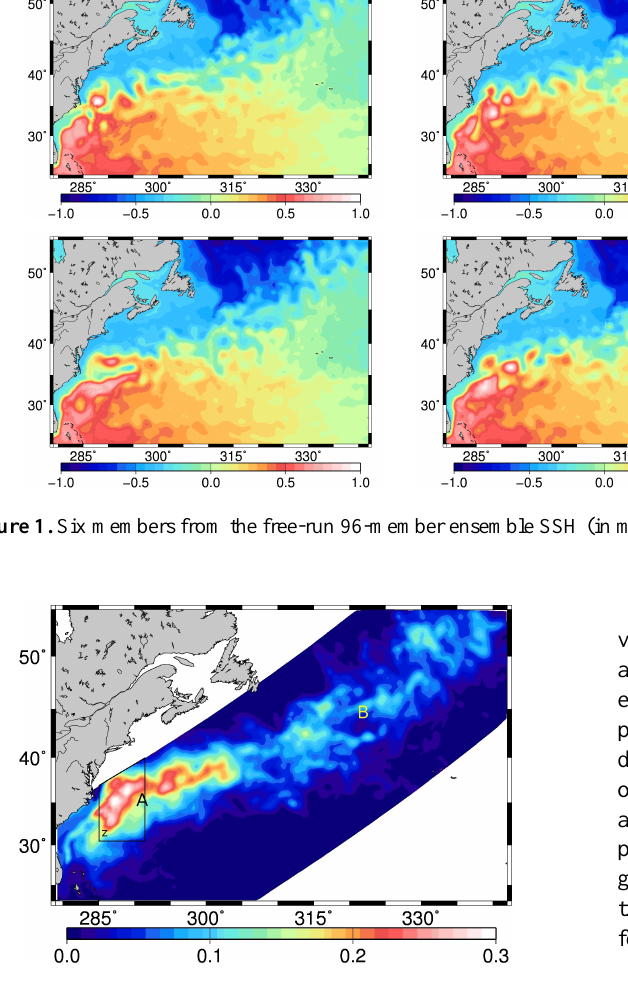
Figure 2. SSH standard deviation (in m) for 9 July 2005. The figure also shows the verification area (in colour) used for the numerical diagnostics together with the smaller focus area Z. Points A and B are particular locations used for diagnostics discussed elsewhere in the